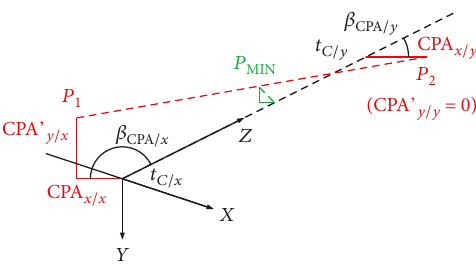
Figure 1: Special points along the 3D A/C trajectories. The dashed line between P and P is the straight trajectory of the intruder. Note 1 2 is in the X - Z horizontal that β CPA/ x